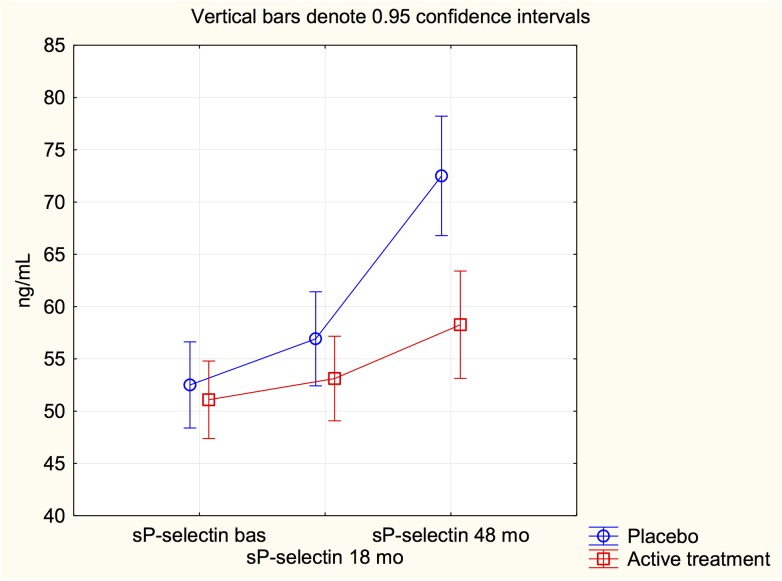
Graph illustrating sP-selectin measurements at study start, after 18 months and at study stop at 48 months in the study population given selenium and coenzyme Q10 combined, or placebo.Note: Analysis according repeated measures of variance.